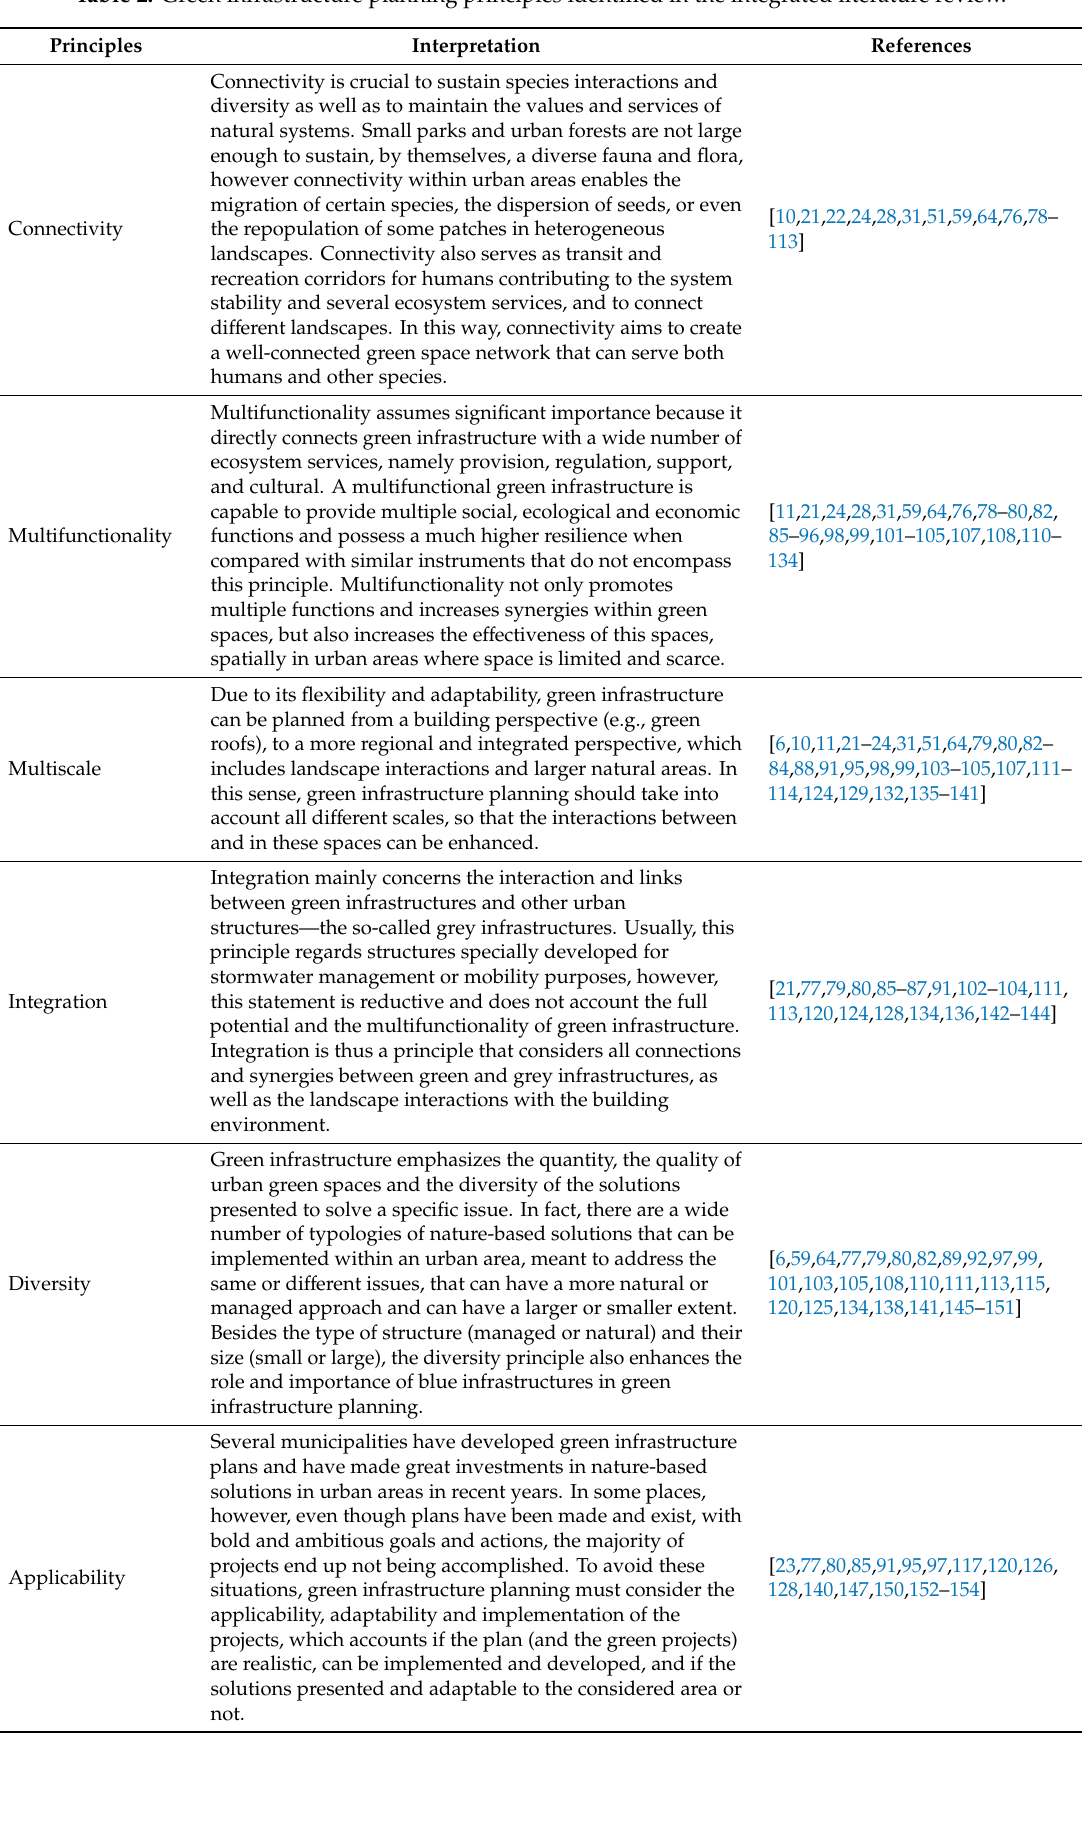
Table 2. Green infrastructure planning principles identified in the integrated literature